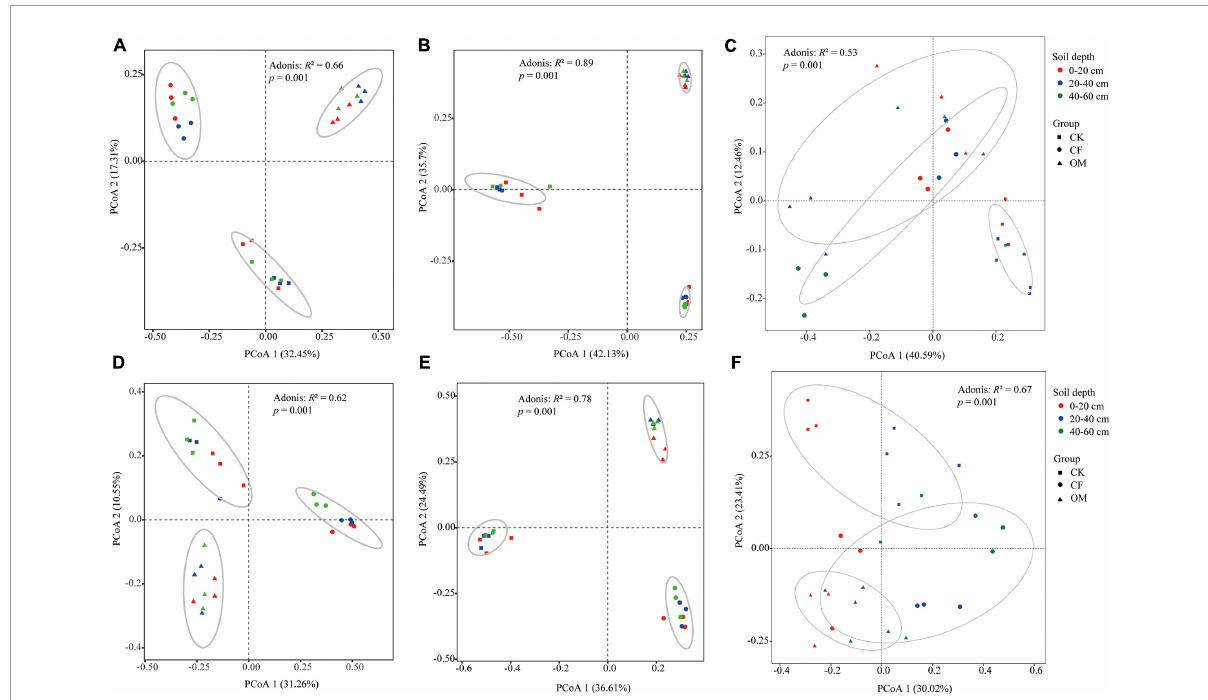
FIGURE2 Principal coordinate analysis (PCoA) ordinations of the bacterial (A,D) , fungal (B,E) and nematode (C,F) communities based on Bray–Curtis distance metric in different soil depths. The up-row is the samples in the year of 2019, and the down-row is in the year of 2020. The top value of each plot indicates the fertilization effect on the microbial and nematode communities in analysis of variance (ANOVA) at a significance level of P < 0.05. CK, no fertilization; CF, chemical fertilization; OM, organic